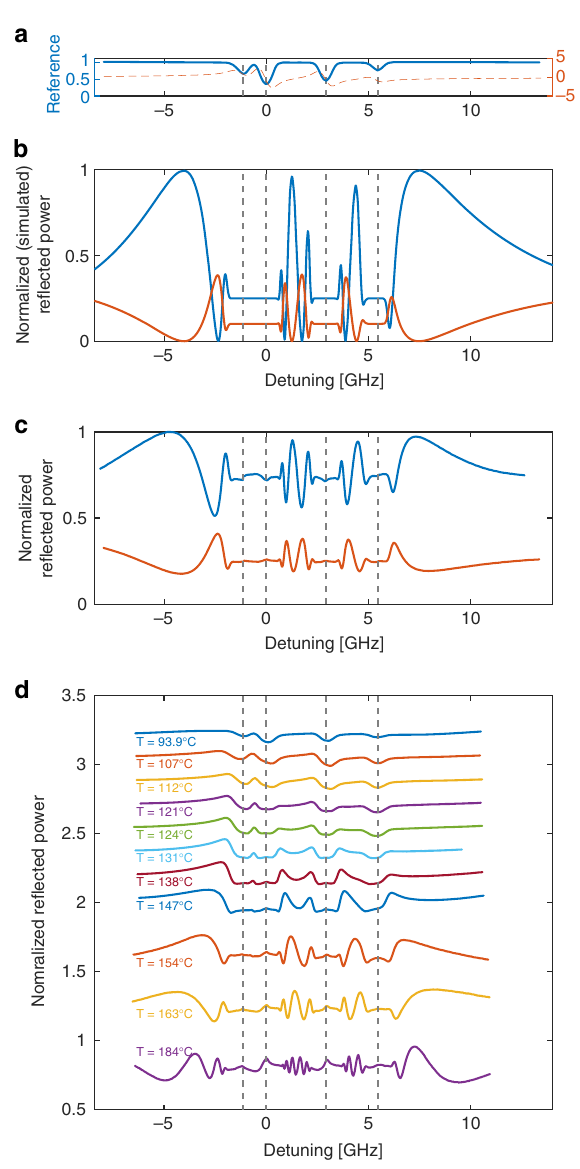
Fig. 2 Atomic diffraction grating spectroscopy. a Reference D2 rubidium absorption and calculated phase spectrum. The 0 GHz detuning is in reference to the 85 Rb F = 3 state, and the phase plot is in units of 2 π . b , c Spectra of zero-order (blue) and fi rst-order (orange) atomic diffraction grating, measured by combining a photodetector and a pinhole in the far- fi eld ( b ) calculated ( c ) measured spectra ( d ) evolution of the measured fi rst-order spectra as a function of atomic density, demonstrating the evolving of the spectra from being absorptive to power pro fi le incident on the CCD as the distance between the atomic lens and the CCD is changed. Figure 3c and d illustrates two different frequency detunings, − 3.4 GHz and − 2.4 GHz, respectively, which strongly modify the properties of the lens and effectively switch between focusing and not focusing the beam at